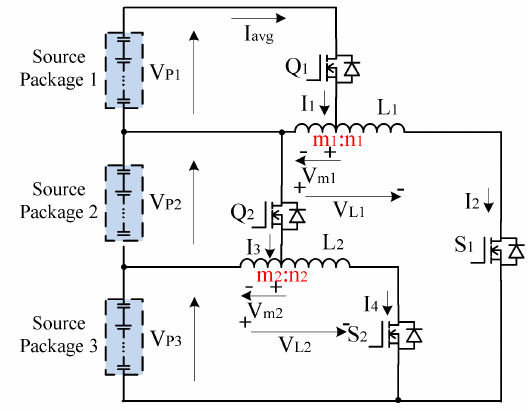
Figure 7. Topologies for